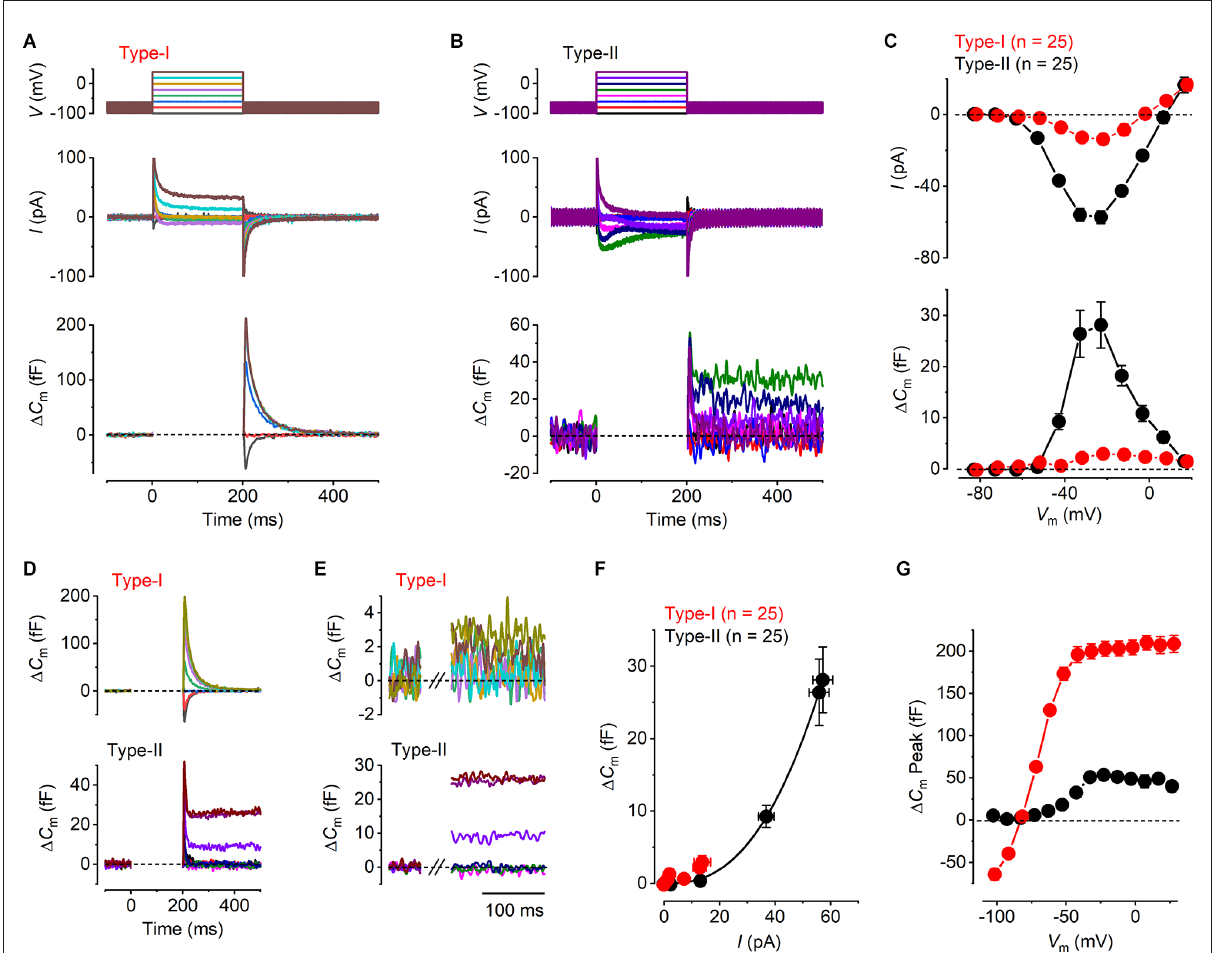
FIGURE2 Ca 2+ currentsandCa 2+ dependentexocytosisinmaturemouseutricularhaircells. (A,B) Representative I Ca (middlepanels)andthecorresponding ∆ C m (lower panels) from a type-I and a type-II hair cell, respectively. The voltage protocol (upper panels) consists of a sine wave (thick solid line) interrupted for the duration of the voltage steps. I Ca was obtained in response to 200 ms voltage steps, from − 101 mV to − 21 mV in 10 mV increments, from the holding potential of − 81 mV. Voltage steps eliciting I Ca produced a sustained ∆ C m in the type-II hair cells, but a large transient ∆ C m in type-I cells. The transient ∆ C m was positive or negative following depolarizing or hyperpolarizing voltage steps, respectively. (C) Mean peak I-V relation (upper panel) and the corresponding mean sustained ∆ C m - V relation (lower panel) for type-I (red, n = 25) and type-II (black, n = 25) hair cells. (D) Averaged ∆ C m traces at potentials up to the peak of the I - V and ∆ C m - V curves in (C) ( − 21 mV), for type-I (upper panel) and type-II (lower panel) hair cells. Note the different scale y-axis used for type-I and type-II hair cells. (E) Same average ∆ C m traces shown in (D) but on a magnified time scale where the transient ∆ C m has been omitted and the ∆ C m response is sustained and stable. This was the region used to measure the sustained ∆ C m response. (F) Synaptic transfer relations for mature type-I and type-II hair cells, which were obtained by plotting the mean ∆ C m values against the corresponding mean I Ca , between − 71 mV and − 21 mV from the I - V and ∆ C m - V curves in (B) . Data from type-II hair cells were fitted according to the power function (see “Methods” Section). (G) Mean transient ∆ C m peak amplitudes in type-I ( n = 25) and in type-II ( n = 25) hair cells. Note that the peak transient ∆ C m was negative in type-I following voltage steps more hyperpolarized than − 81